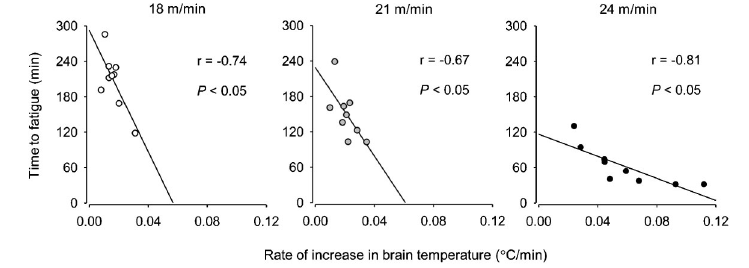
Figure 3. Correlations between total exercise time and the rate of increase in brain temperature calculated from the beginning until the end of constant exercises at three speeds: 18, 21, and 24 m/min. Data are reported as individual values. The Pearson correlation coefficient was used for